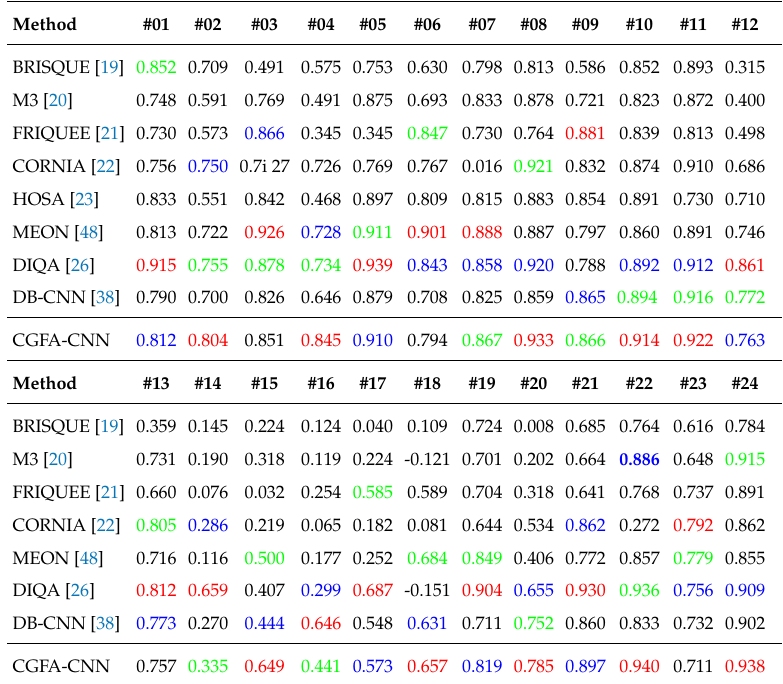
Table 5. Average SRCC results of individual distortion types across ten sessions on TID2013 database. The top three SRCC results are highlighted in red, green, and blue, respectively.